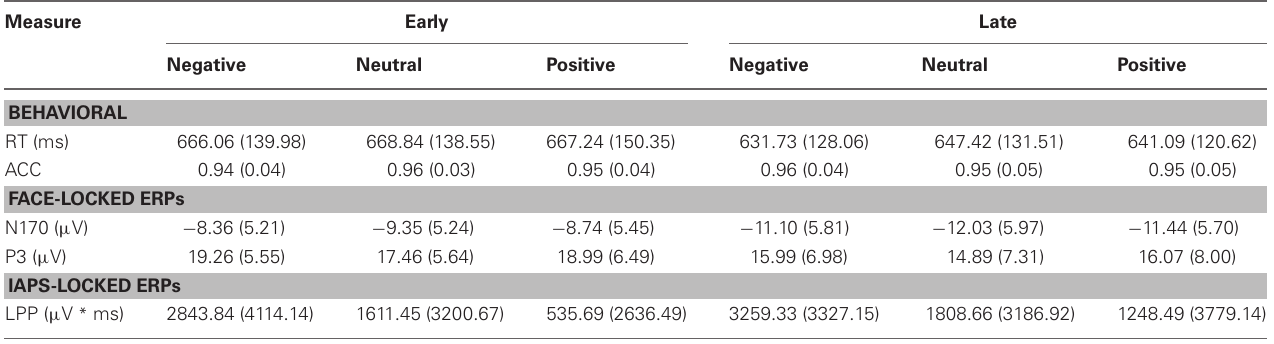
Table 3 | Summary of means (SD) for each dependent measure as a function of picture valence, separately for early and late temporal interval face-targets.